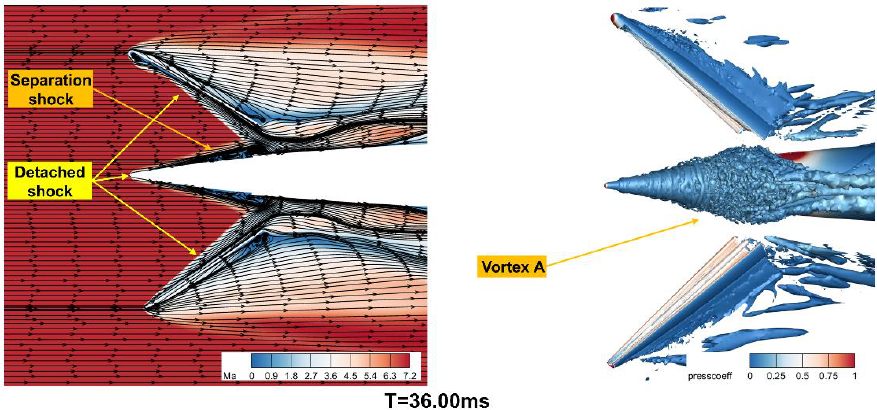
Figure 30. The contour of the streamline and Mach number ( left ), and iso-surface of Q-criterion ( right ) at Time = 36.00 ms.